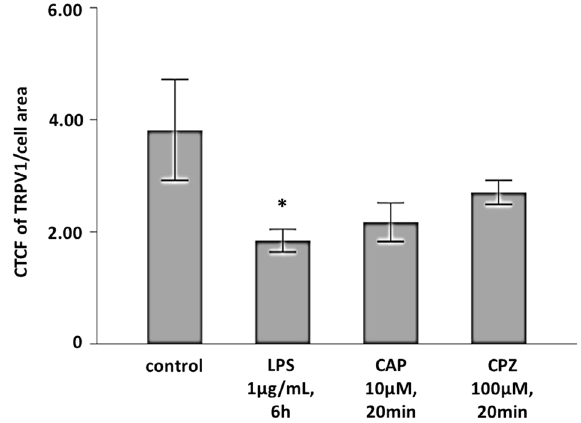
Figure 4. TRPV1 is internalized upon stimulation with LPS, as determined by corrected total cellular fluorescence (CTCF) of the fluorochrome-marked TRPV1 channel. Presented is the mean ± standard error of the mean (SEM). Kruskal–Wallis p = 0.005; * p < 0.05 unstimulated controls versus LPS. Results are derived from two independent experiments. Unstimulated cells, n = 26; n = 8 and n = 18 biological replicates per experiment. LPS (1 µg/mL, 6 h), n = 36; n = 12 and n = 24 biological replicates per experiment. CAP + LPS (CAP 10 µM, 20 min, + LPS, 1 µg/mL, 6 h), n = 29; n = 13 and n = 16 biological replicates per experiment. CPZ + LPS (CPZ, 100 µM, 20 min, + LPS, 1 µg/mL, 6 h), n = 39; n = 9 and n = 30 biological replicates per